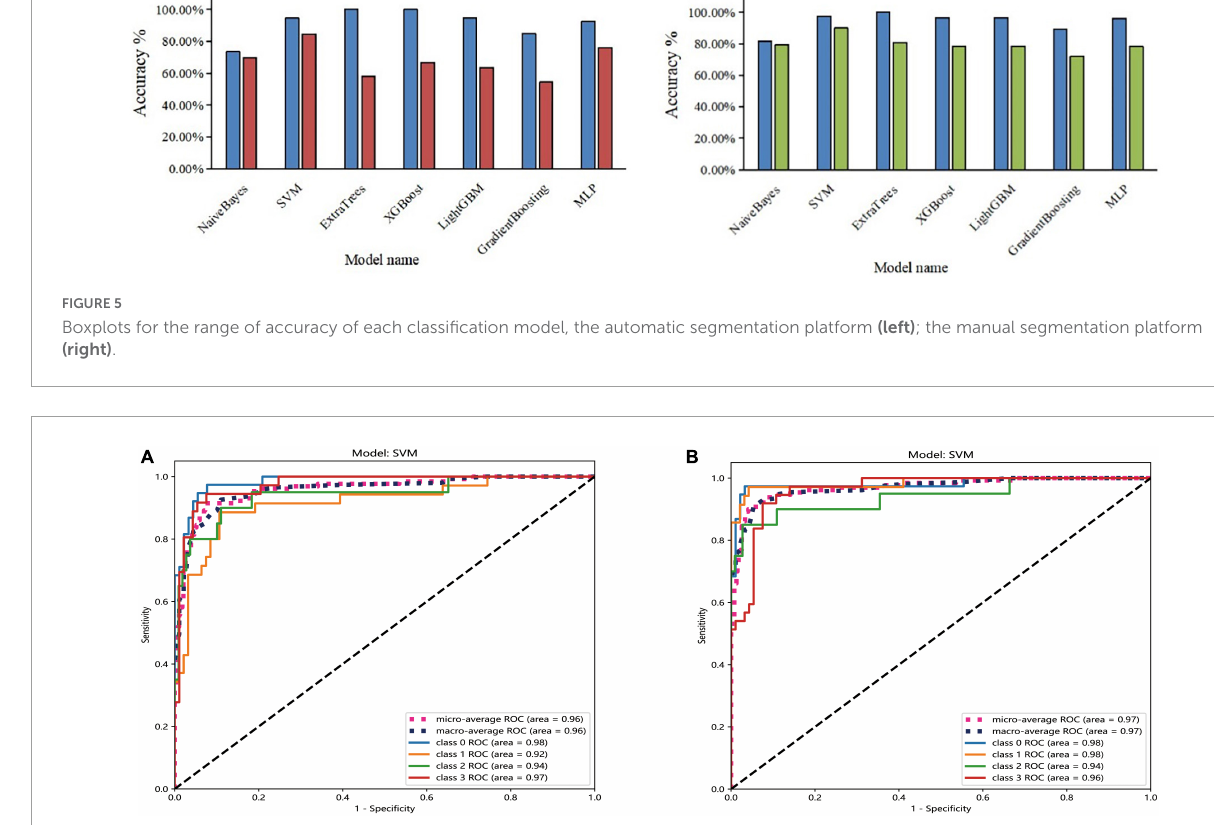
FIGURE6 The ROC curves of SVM model of two different platforms in the test set. The automatic segmentation platform (A) ; the manual segmentation platform (B) , “Class 0” indicated incipient stage, “class 1” indicated intumescent stage, “class 2” indicated mature stage, and “class 3” indicated hypermature stage.